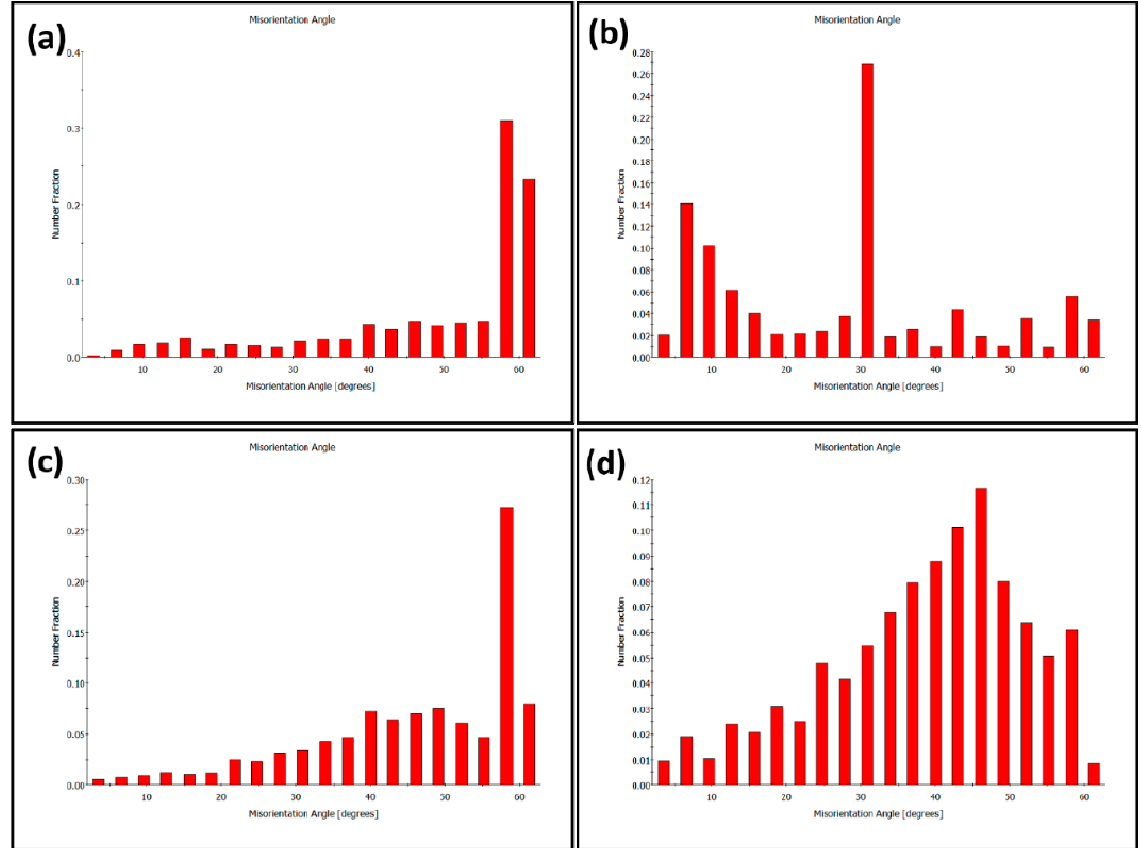
Figure 15. Misorientation angle distribution of BM ( a ) austenite, ( b ) ferrite and NG of FSWed joint ( c ) austenite, ( d )